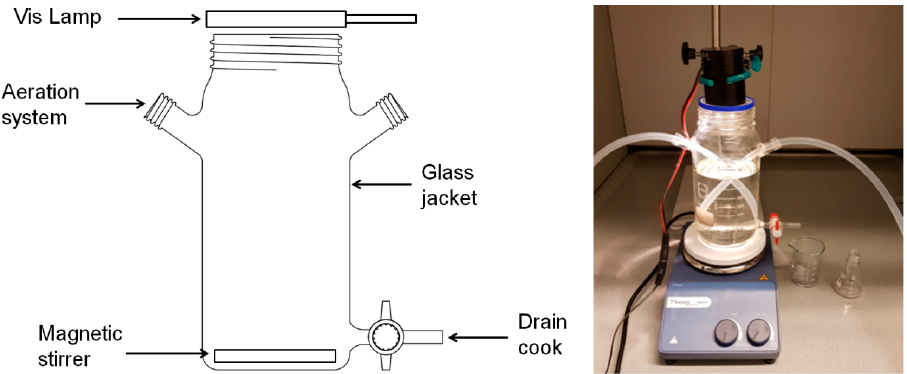
Figure 1. Scheme of conducting the chlorfenvinphos decomposition process under the influence of visible light.